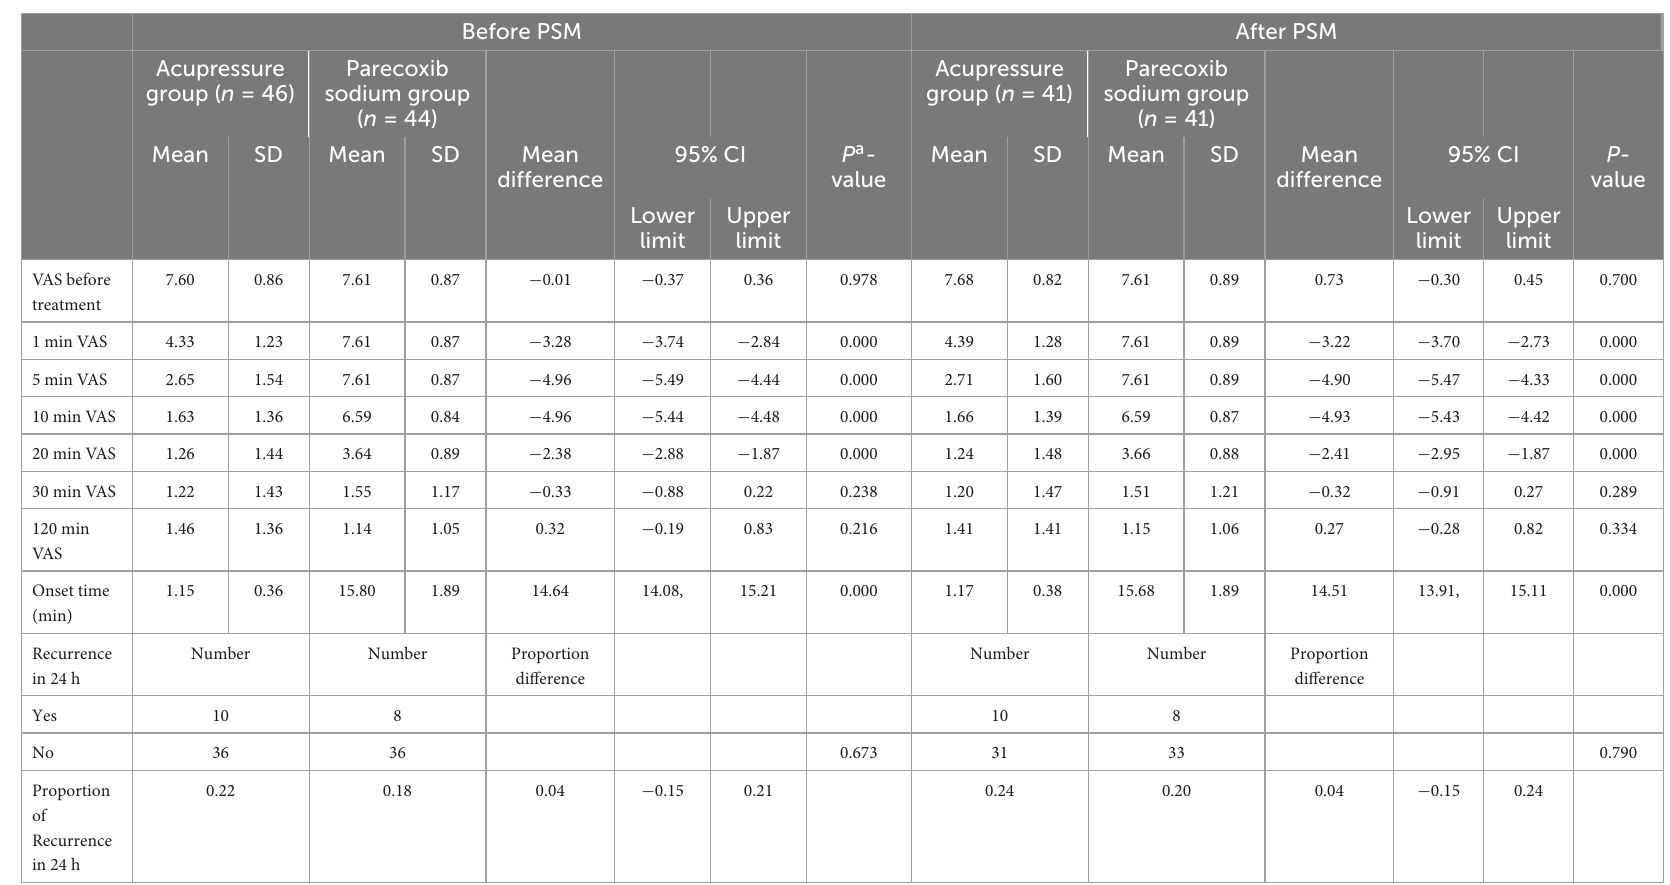
TABLE 2 Outcomes of each